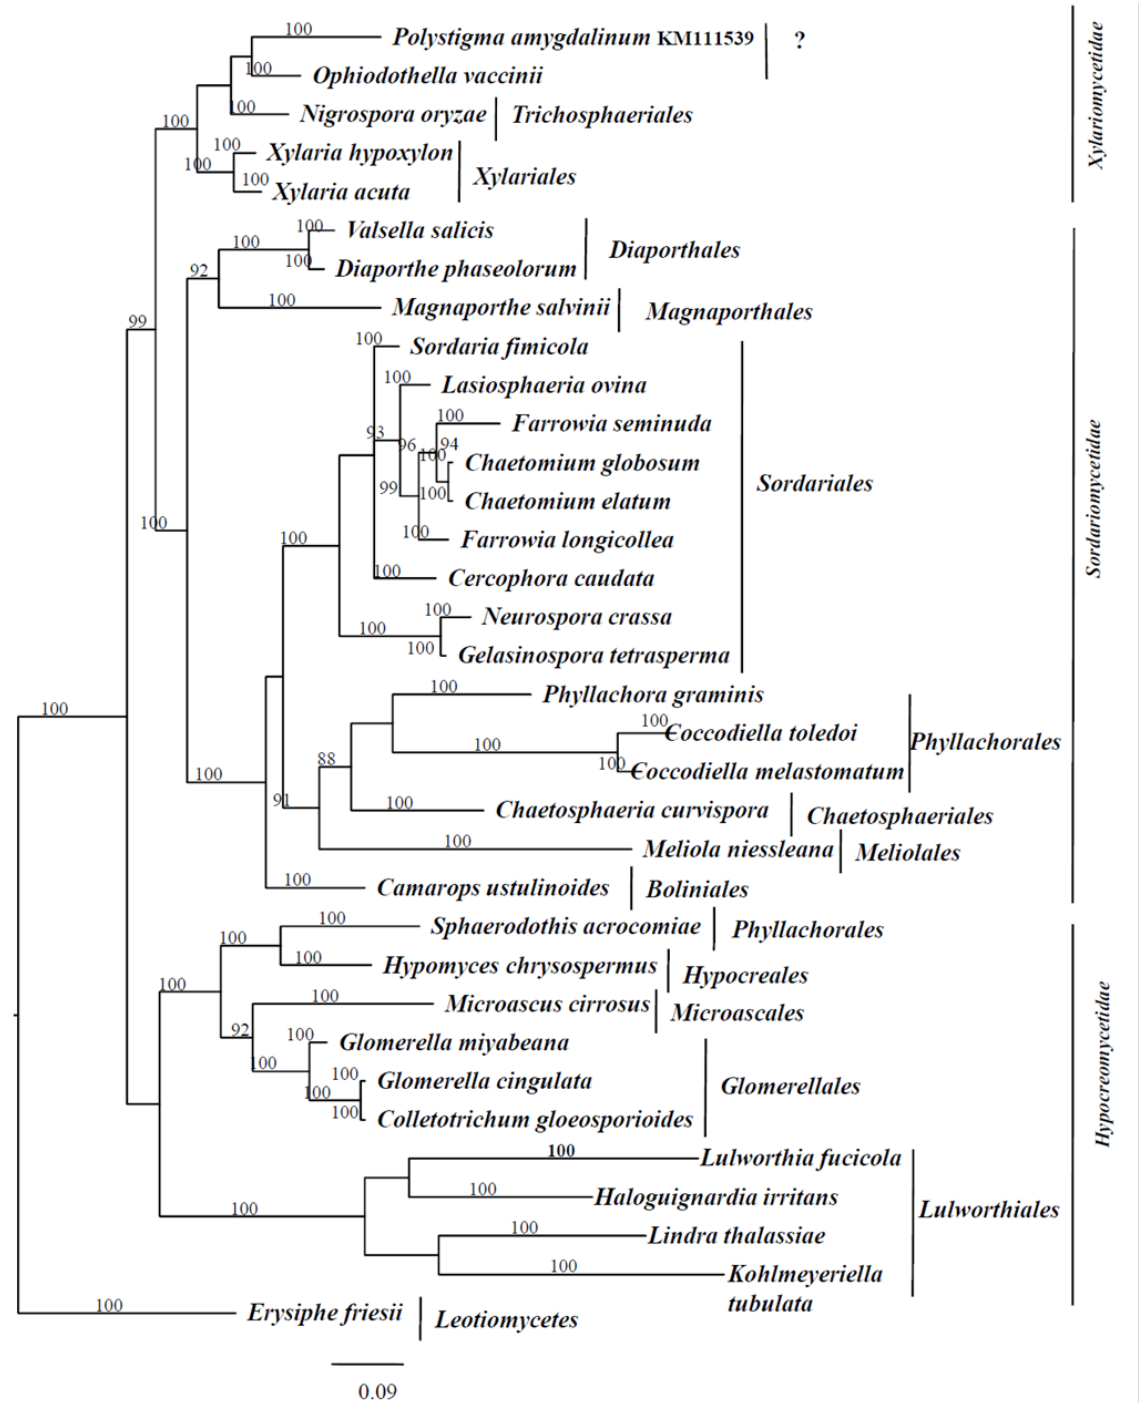
Figure 1. Bayesian phylogenetic tree of species belonging to different orders of Sordariomycetes based on SSU rDNA se- quences. Bayesian posterior probabilities (probability %) are shown next to the branch points. The scale bar represents the number of changes per